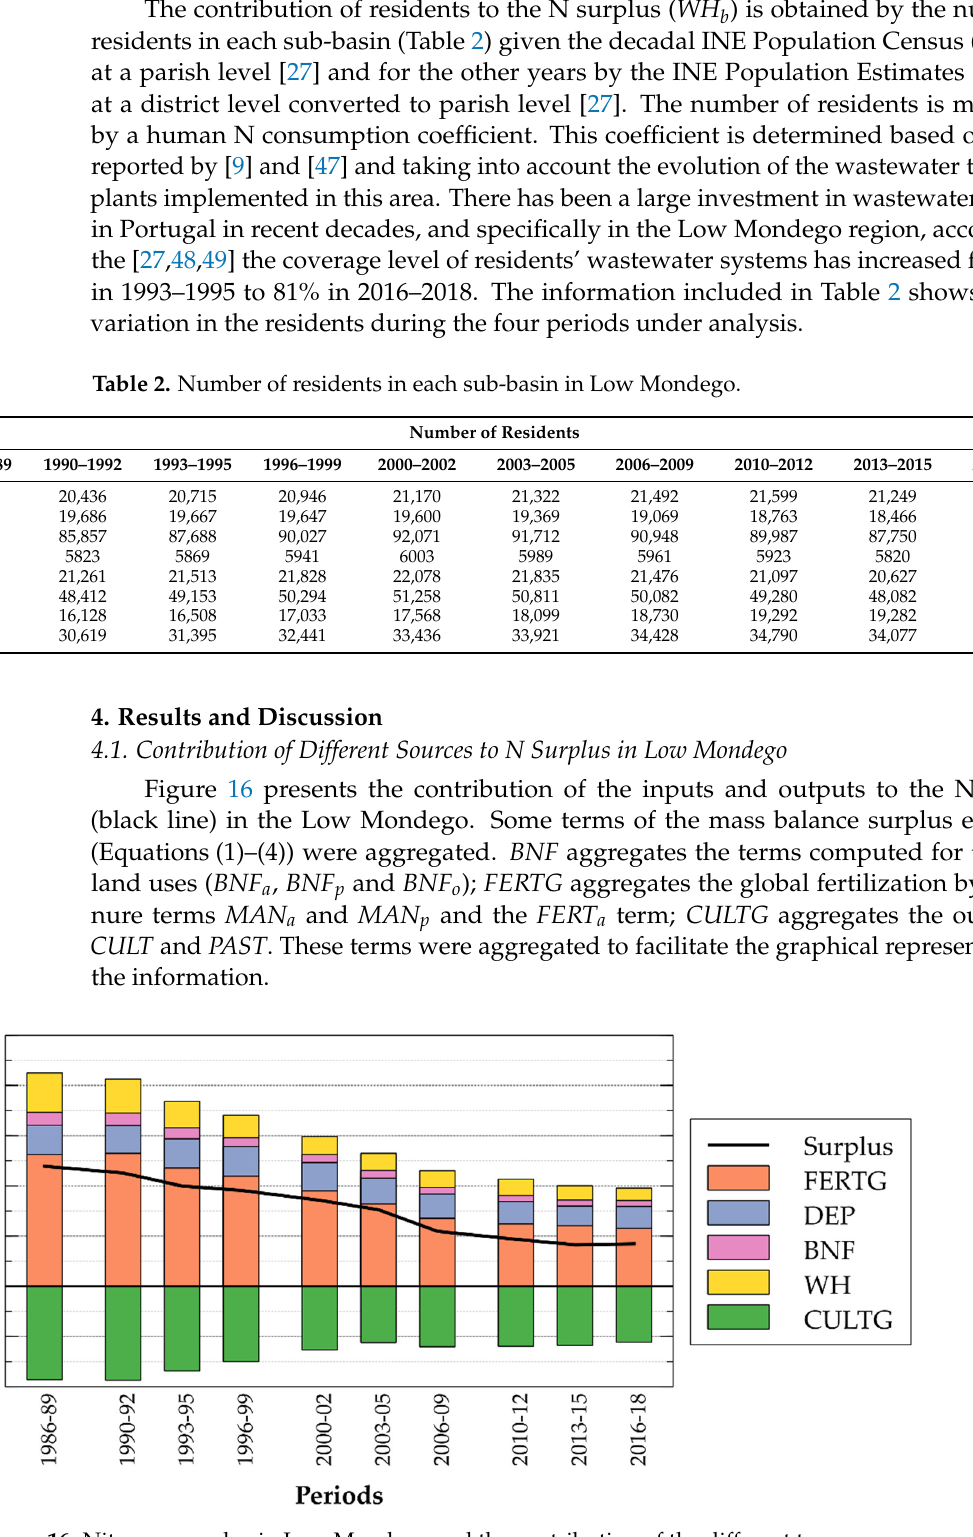
Figure 16. Nitrogen surplus in Low Mondego and the contribution of the different terms. Overall, the N surplus in the Low Mondego decreases from 23.9 kg N/ha/yr in the first period to 8.44 kg N/ha/yr in the last period (black line). This decrease is influenced by the reduction in all input components. The BNF is the one with the lowest contribution and the FERTG represents a major contribution to the inputs of N surplus with mean percentages of 62% of the total N inputs (Figure 17). The FERTG contributions to the total N inputs of the Low Mondego confirms that the agriculture sector is the main source of N. This was also the main driver of the N surplus reductions. The work by [18] found a mean value of 75% for the FERTG (including manure and inorganic fertilization) for the Portuguese Tagus river sub-ba- sin. This may be associated with higher agricultural sector activity, with agricultural areas of 52% (relatively to the total basin area) on average in terms of the studied period, which com- pares with the average area of 23% of Low Mondego. The CULTG (green bars in the Figure 16) also decreased from 18.6 to 11.1 kg N/ha (a 40% decrease), but this fall was lower than the decrease of 48% in the crop land use in the Low Mondego (Figure 14), and this means there was an increase in crop productivity in those areas that retained agriculture, mainly in the agricultural blocks. This crop productivity increase also contributes to the reduction in the N surplus in the Low Mondego to values that are quite lower than those estimated by [16] with values of 15 and 30 kg N/ha/yr between 1995 and 2015 for the whole country of Portugal. The contribution in percentage of terms to the N input for years 1986–1989 and 2016– 2018 is displayed in Figure 17. This is thirty-two years where drastic changes happened not only due to measures related to new environmental legislation ( DEP and HW ), but also to changes in agricultural practices, to changes in social context and to the decrease in importance of the agricultural sector in the Low Mondego area ( BNF and FERTG ). Figure 17. Contribution of the input N terms to the nitrogen surplus in the Low Mondego in peri- ods 1986–1989 and 2016–2018.